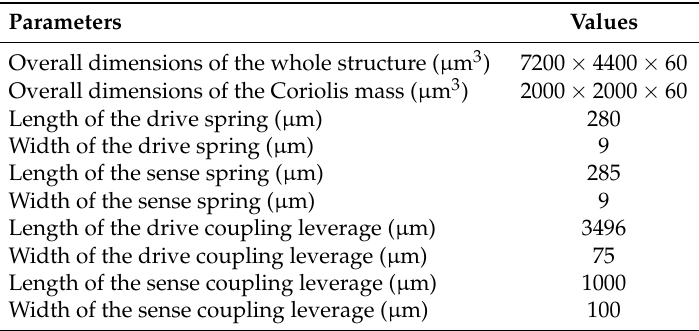
Table 1. The main parameters of the structure.